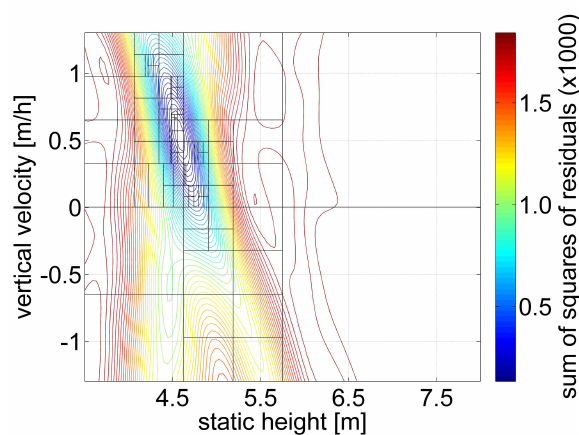
Figure 5: Contour plot of the cost functions with the investigated intervals boxes.